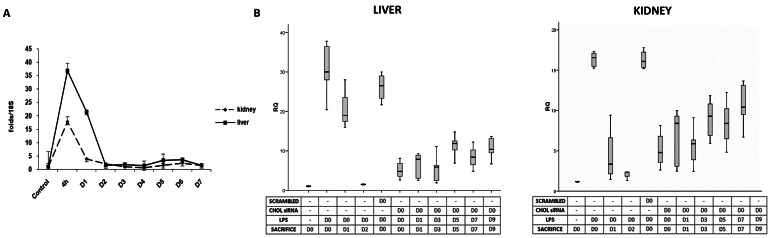
In vivo CD40 expression after LPS stimulus and Chol-siRNA.A) ) Kinetic of CD40 expression in liver and kidney after LPS injection, a peak of CD40 expression at 4 h was seen. There were no differences using scrambled siRNA. B) Pharmacodynamic evaluation of Chol-siRNA. Mice receiving a single dose of Chol-siRNA at day 0 and a single injection of LPS at pre determined time points showed reduction on liver and kidney CD40 gene expression. Data are expressed as mean± SEM of four separate experiments.